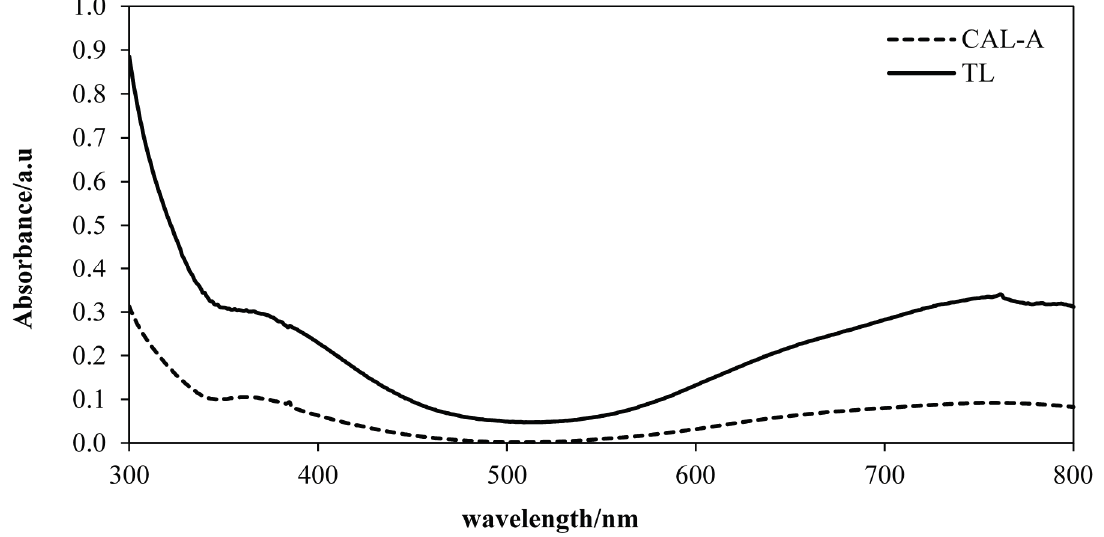
Figure 5. Absorbance spectra for FHA-V(V) complex after the aminolysis reaction using different types of enzymes. Reaction conditions: Crude palm oil, 6 mmol; hydroxylamine hydrochloride, 2 mmol; CAL-A lipase, 20.0 mg; TL lipase, 20.0 mg; hexane, 3 mL; deionized H 2 O, 3 mL; V(V) ion solution, 300 µL; temperature, 70 °C; shaking rate, 150 rpm; reaction time, 60